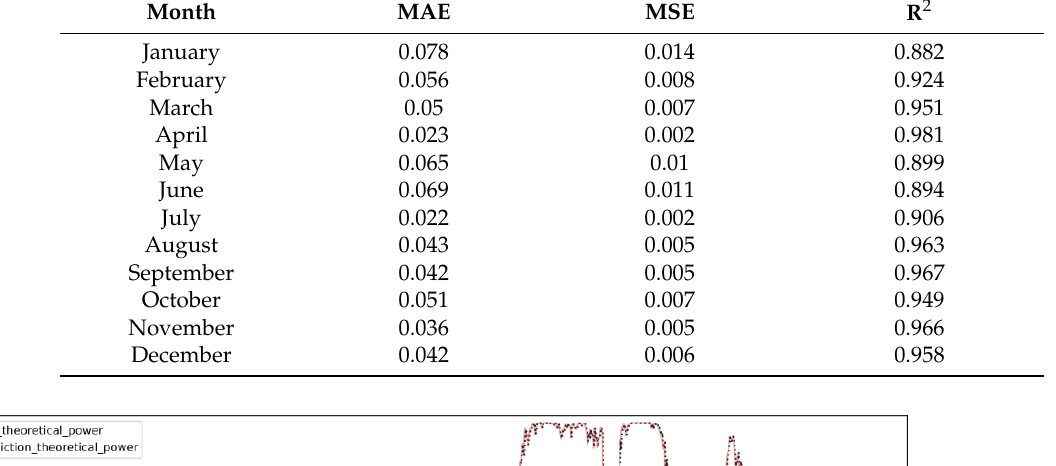
Table 5. The performance measures of theoretical power prediction over the test set for the whole